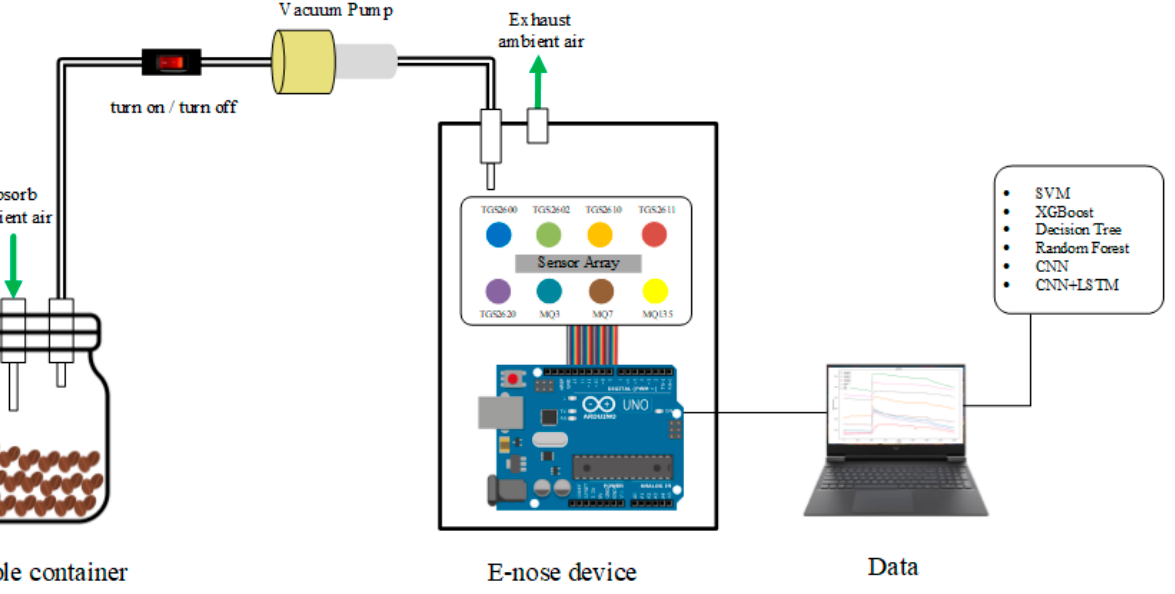
Figure 3. Developed e ‐ nose system prototype and configuration.